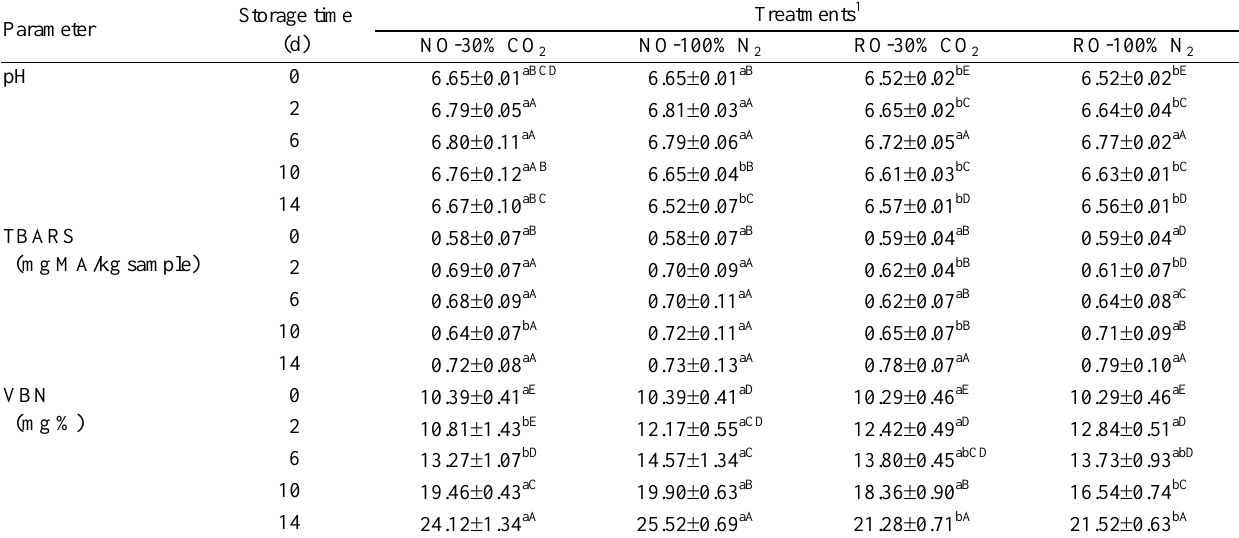
Table 2. The effect of modified atmosphere packaging (MAP) and additive mixture on pH, 2-thiobarbituric acid reactive